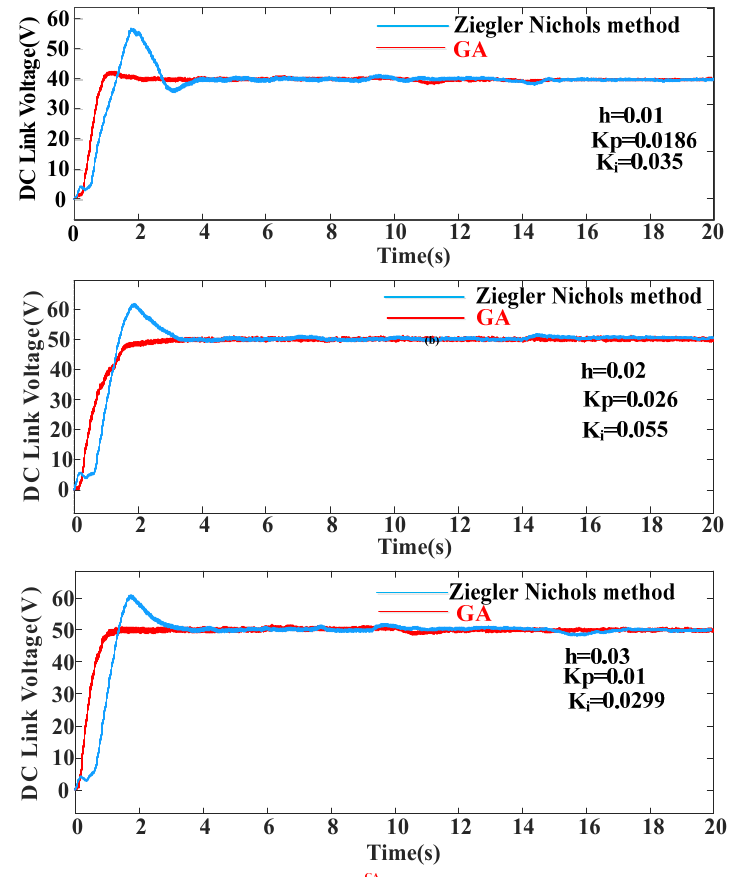
Figure 8. DC link voltages at different hysteresis band values.